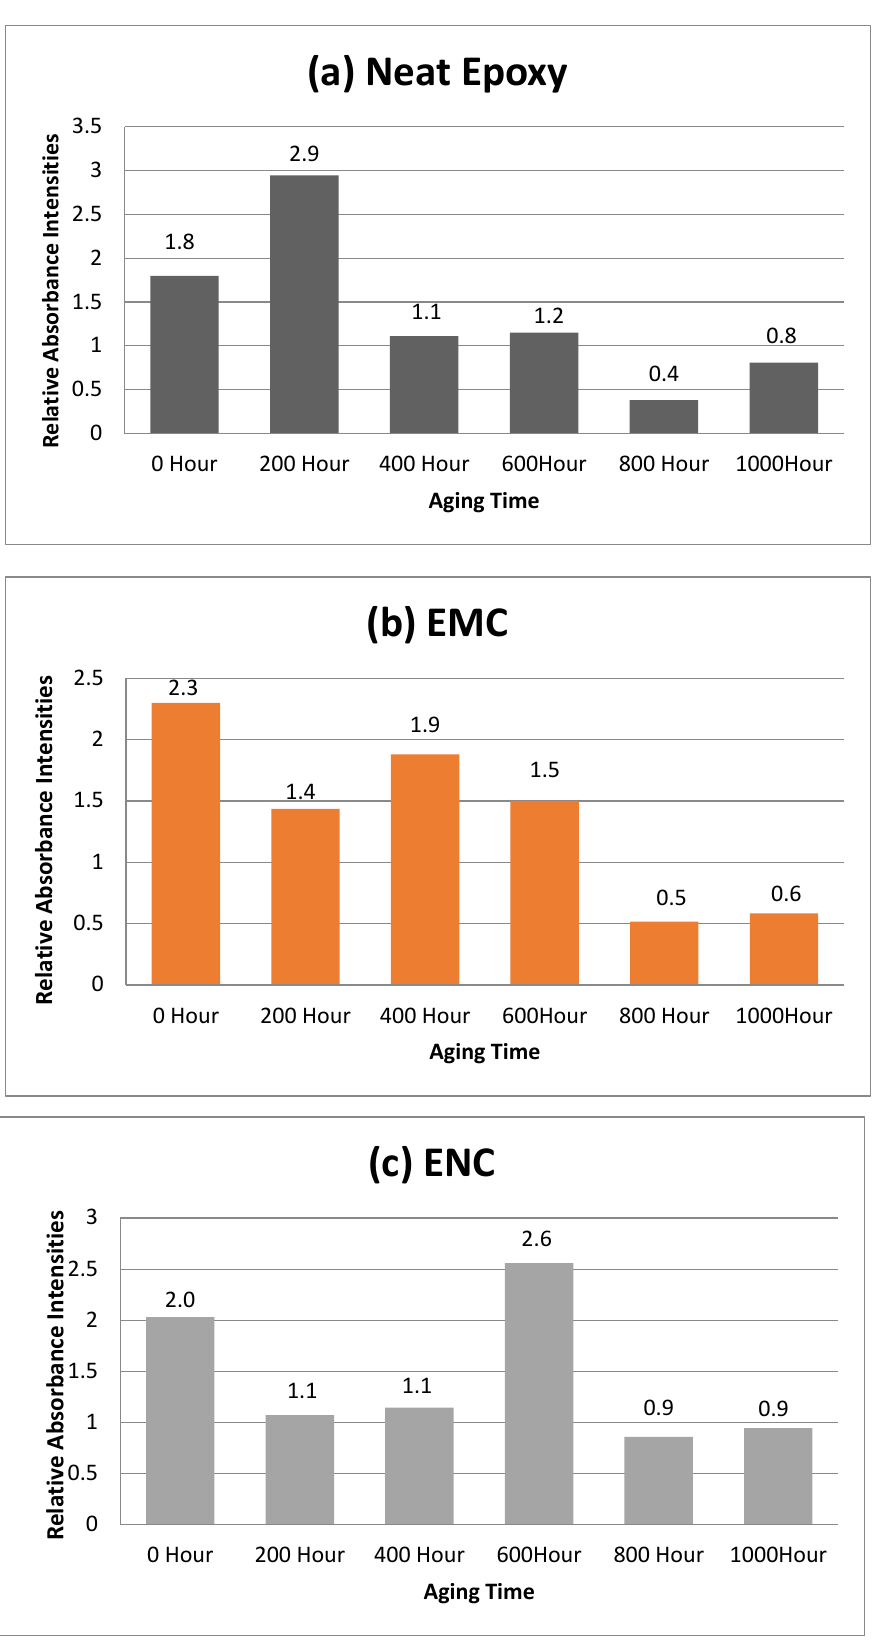
Figure 14. Changes of relative absorbance intensities of epoxy functional groups with long term hydrothermal aging.